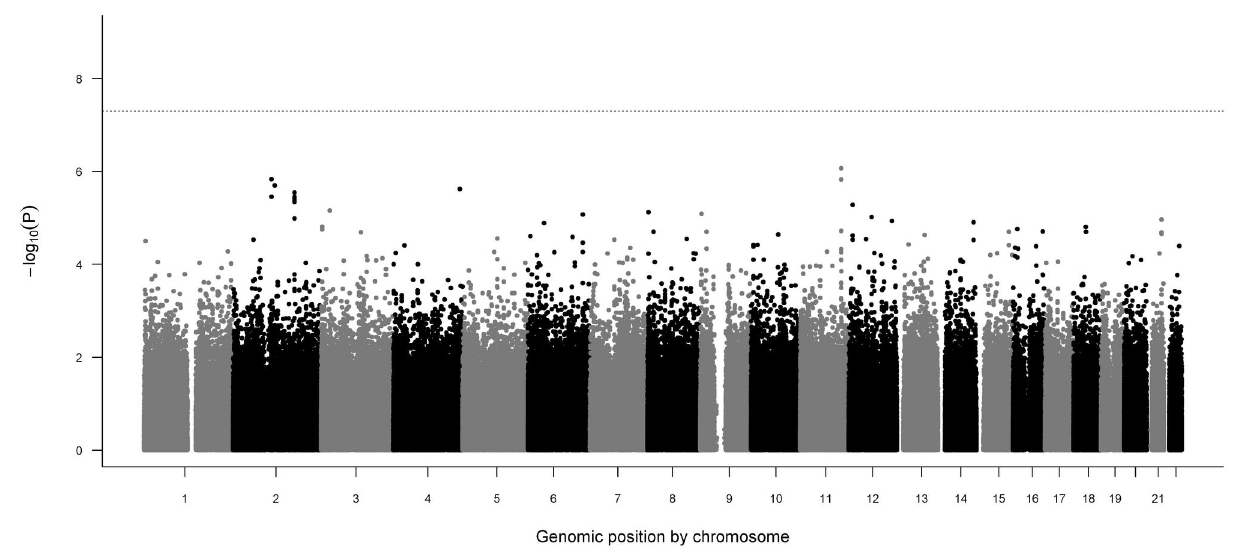
Figure 1. Manhattan plot showing the association of SNPs with systolic blood pressure (SBP). The genome-wide distribution of -log P-values are plotted against the physical position of each SNP on each chromosome. The threshold for 10 genome-wide significance (P-value < 5.0x10 -8 ) is indicated by the horizontal dashed line. doi: